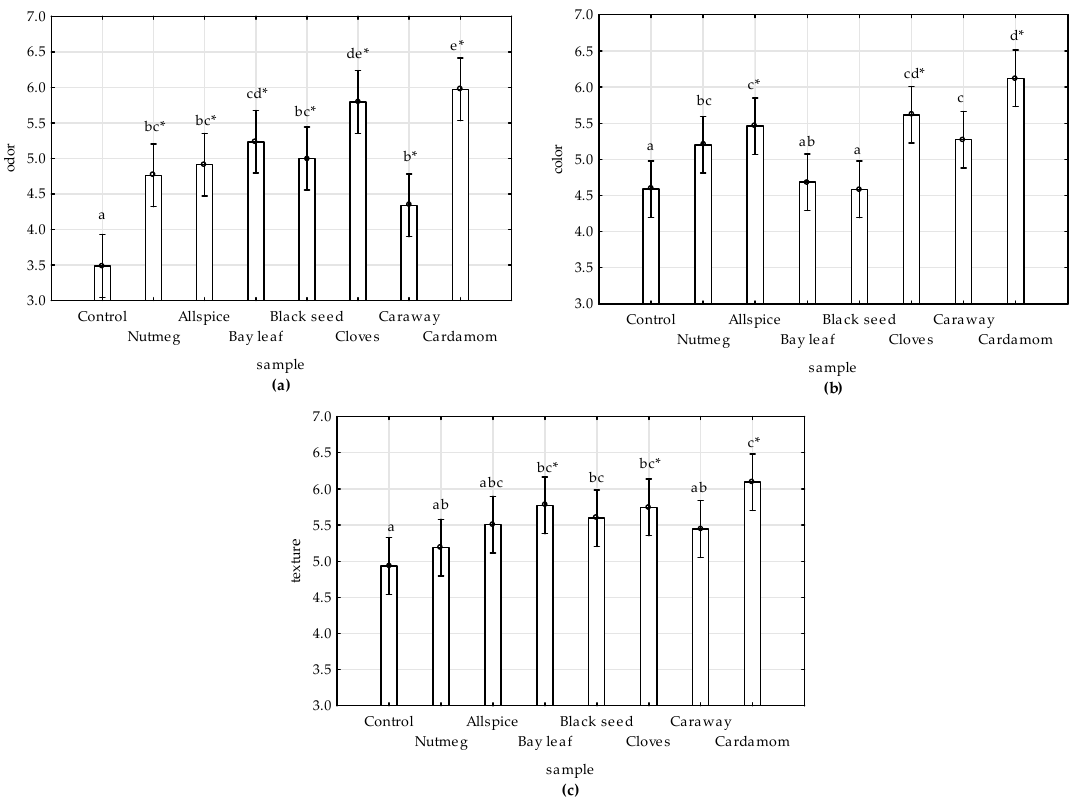
Figure 5. Effect of various spice extract treatments on sensory attributes: ( a ) Odor, ( b ) color, and ( c ) texture of raw ground chicken meat stored at 4 °C during 12 days. Columns present total mean values (from ANCOVA analysis); vertical bars denote 0.95 confidence intervals, and means with the same superscript are not different ( p > 0.05, Duncan’s test). *indicates significant difference of the sample from the control one ( p ≤ 0.05, Dunnett’s test).